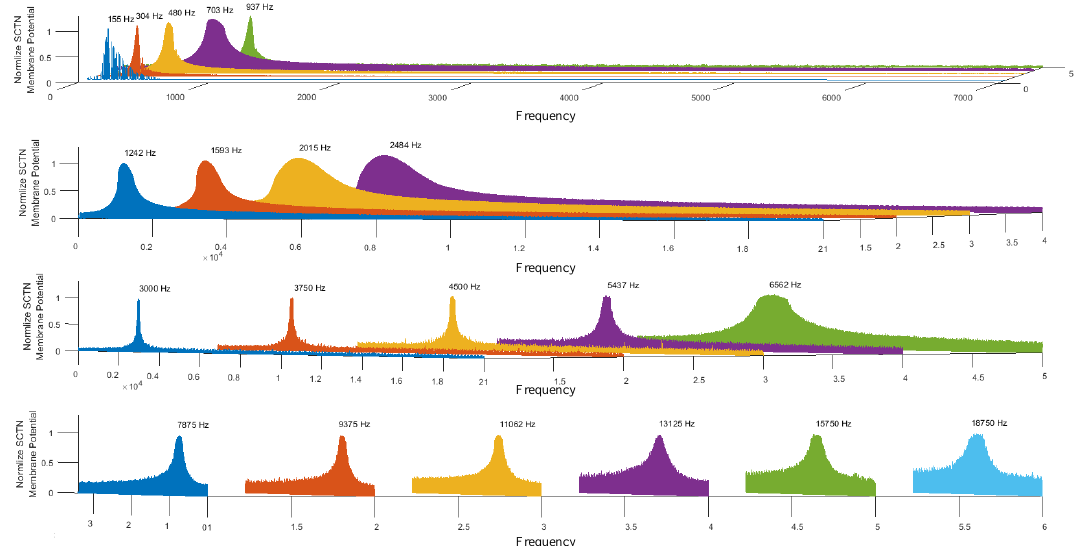
Figure 6. SCTN-based resonators’ bank (the parameters are tuned to detect 20 predefined frequencies in the audio spectrum). This approach can be easily applied for extracting the common MFCC coefficients representing a sound signal. Each resonator can be configured to detect a relatively closed neighborhood of frequencies around the central detected frequency. The bank of filters can be adapted to identify different types of soundtracks (e.g., female and male, background, noises,